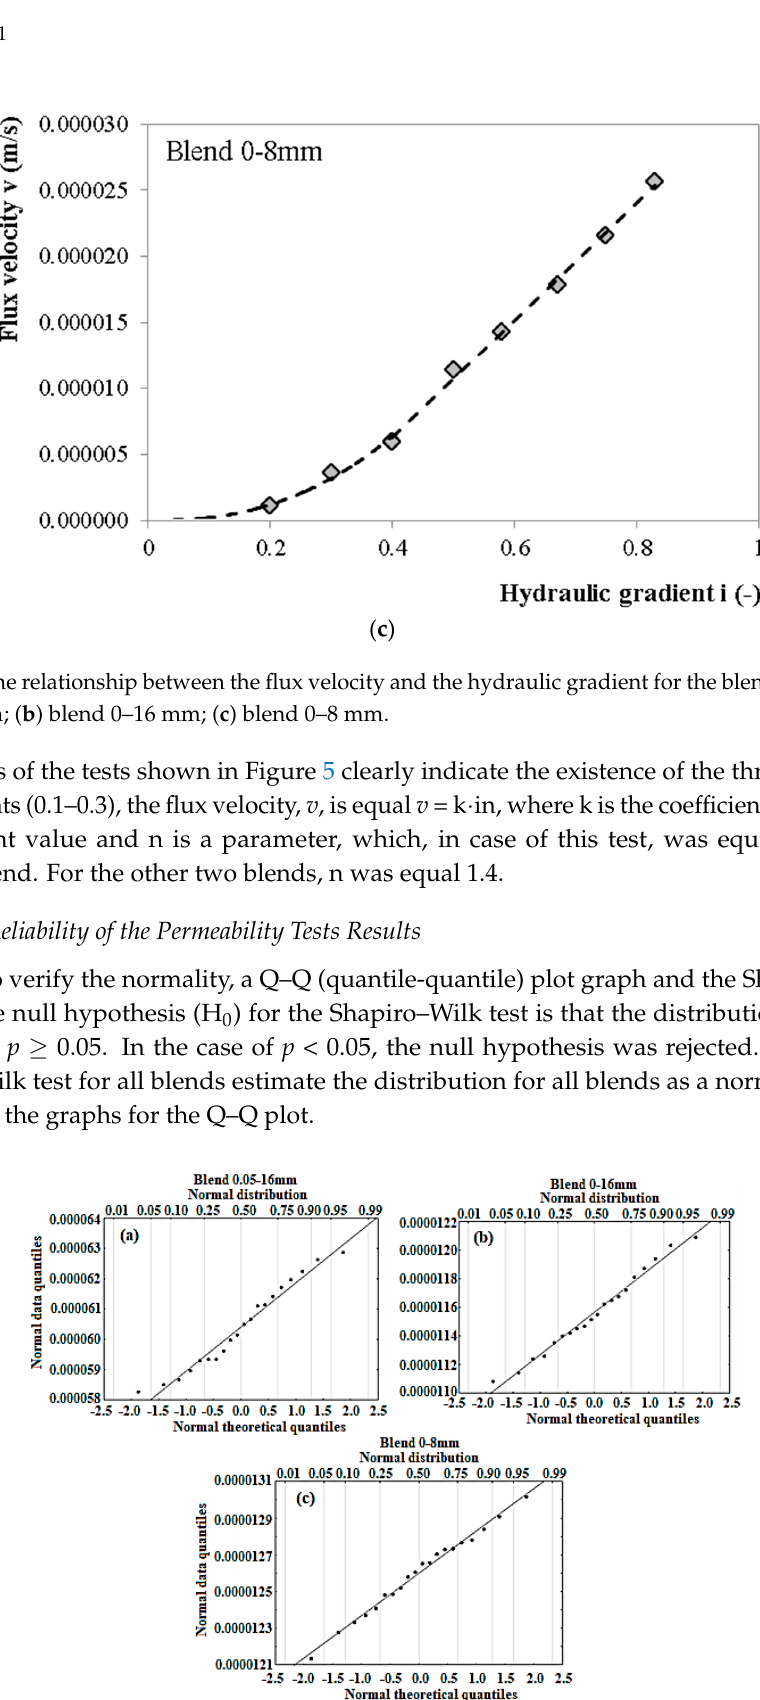
Figure 6. The Q–Q (quantile-quantile) plot graph for the blends. ( a ) blend 0.05–16 mm; ( b ) blend 0–16 mm; ( c ) blend 0–8 mm.